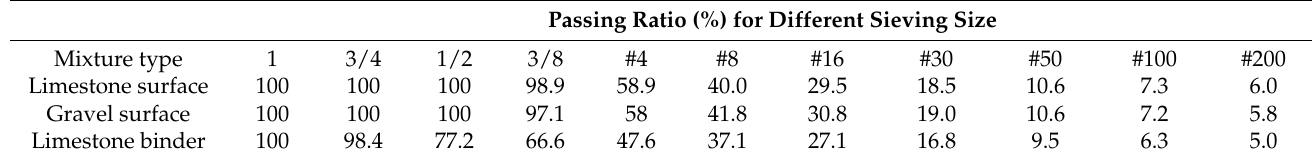
Figure 7. Test sites for validation (after [7]). Table 1. Gradation Information of Different Mixture Types (after